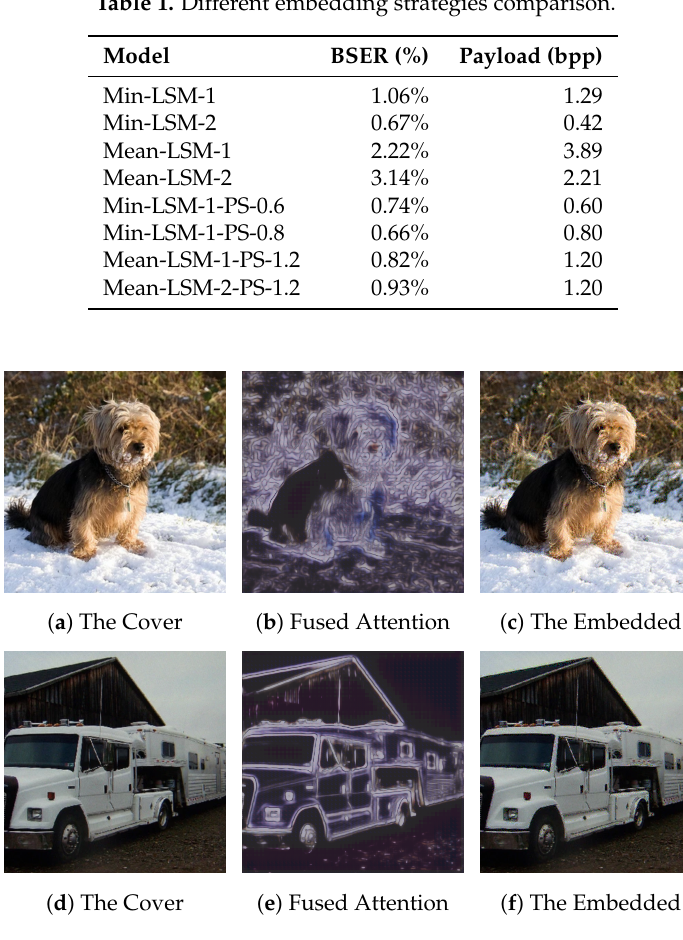
Figure 16. Steganography using Mean Fusion with 1-bit